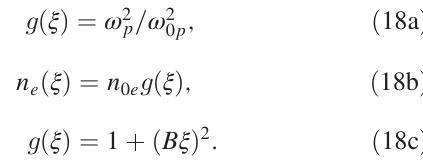
ffiffiffiffiffiffiffiffiffiffiffiffiffiffiffiffiffiffiffiffiffiffiffiffi p 4 π e 2 n represents the initial electron plasma 0 e =m e